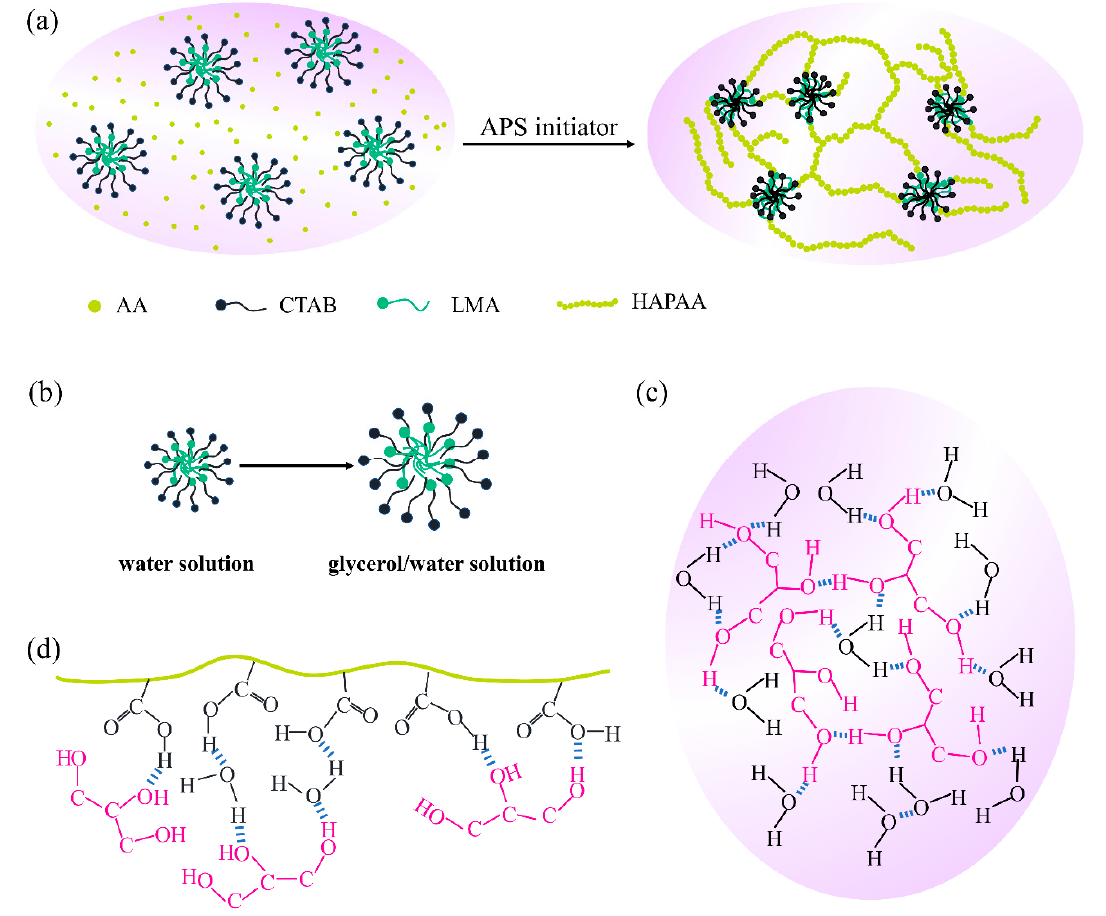
Figure 1. ( a ) Polymerization and the structure of HAG x hydrogels. ( b ) The association of the micelles in water and glyc- erol/water solution. ( c ) Hydrogen bonds between water and glycerol. ( d ) Hydrogen bonds between HAPAA and glycer- ol.